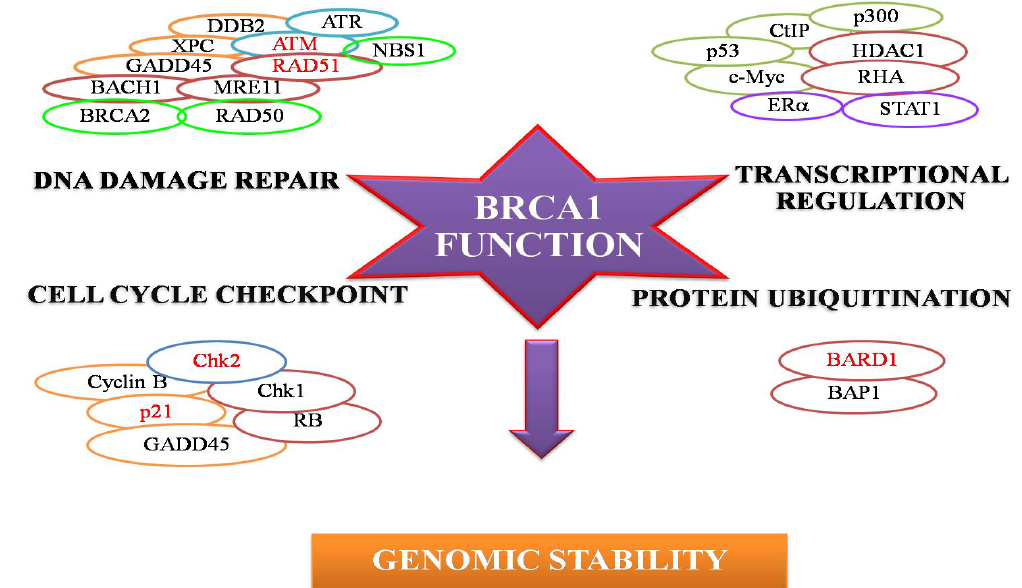
Figure 1. BRCA1 interacting